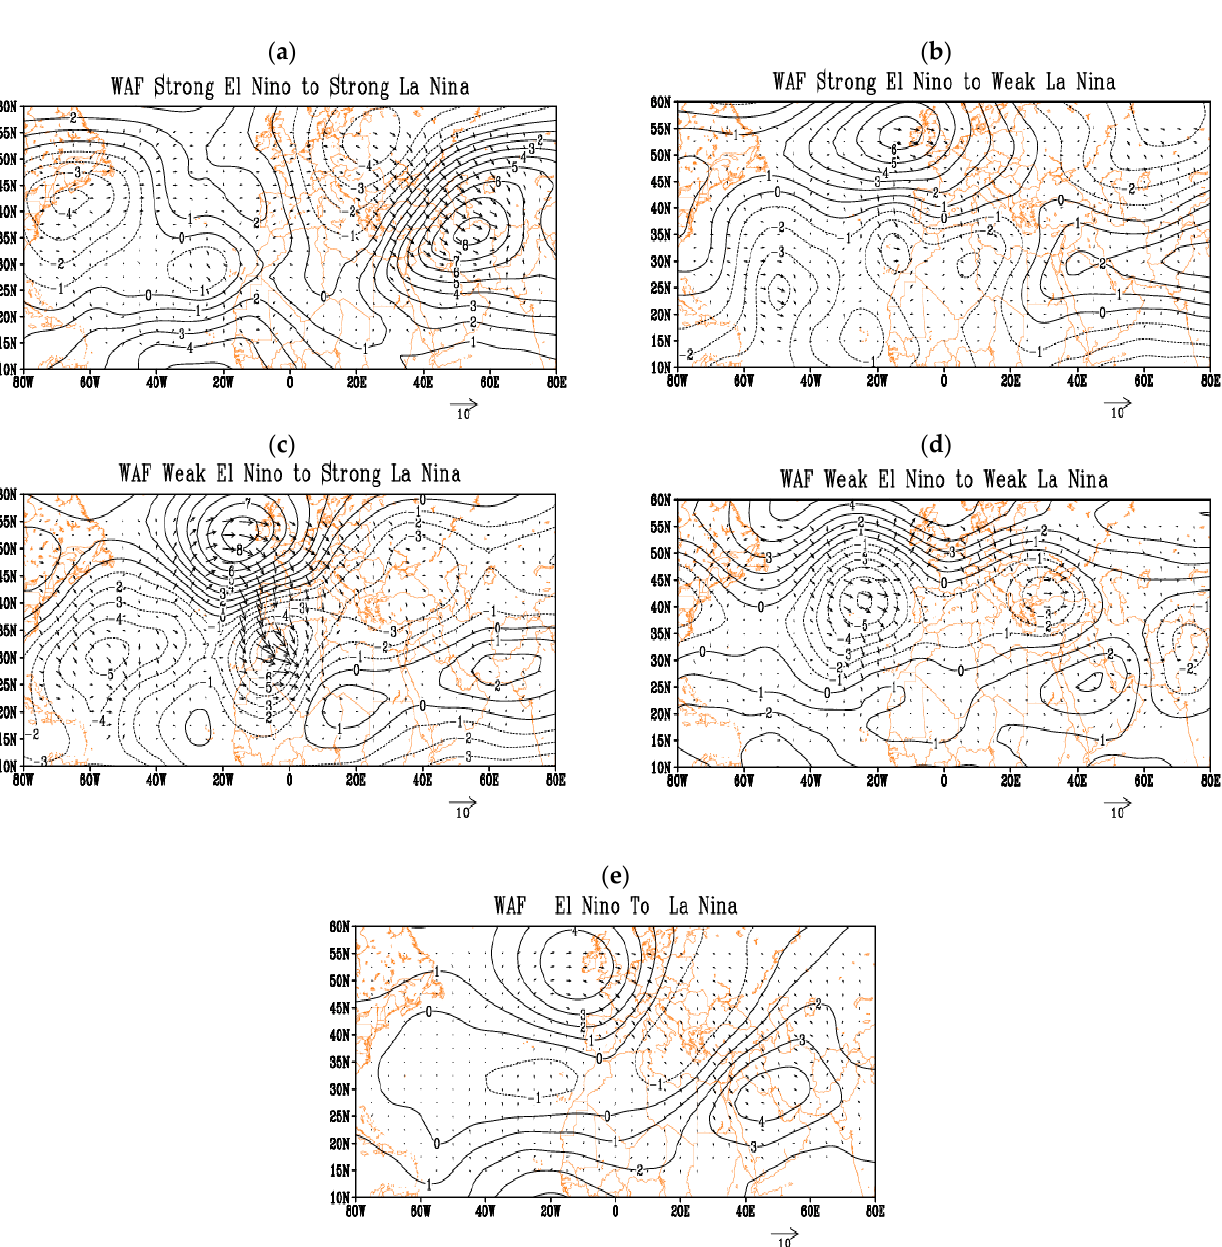
Figure 3. Anomalies in autumn (OND) horizontal flux of wave activity (arrows) and its divergence (contours) for ENSO phase transition type 1 years. The first four panels ( a – d ) show patterns for different cases, while the final panel ( e ) shows the average over all the type 1 year. Units for the arrows are m 2 /s 2 and for contours 10 6 m 2 /s.